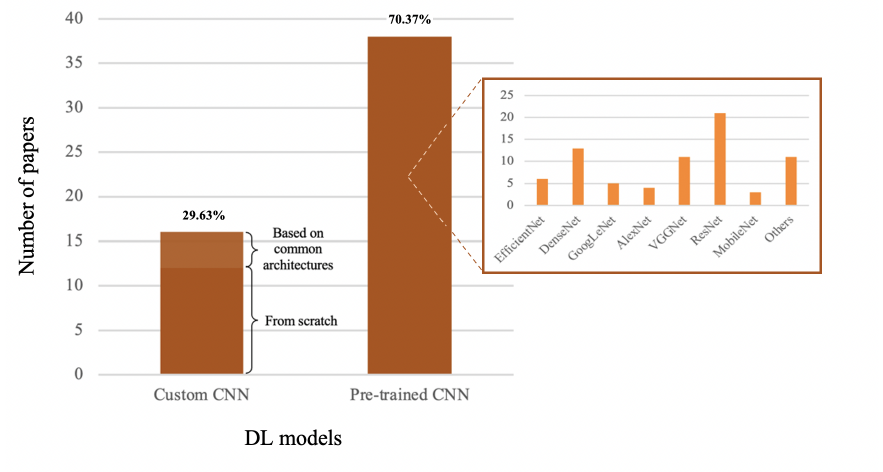
Figure 6. Analysis of the most used DL models, distinguishing between custom CNNs and pre- trained